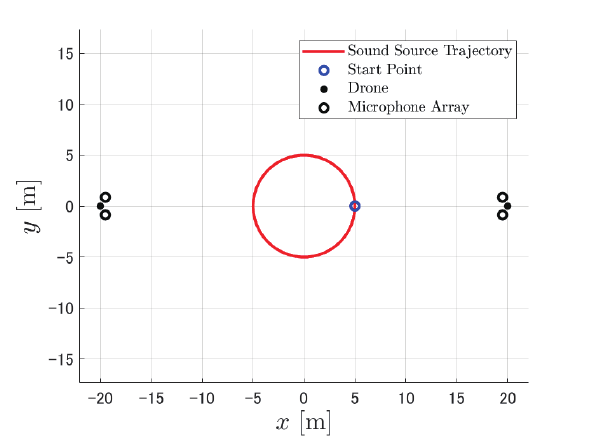
Figure 2. Top view of simulation scenario (horizontal distance = 30 m, sound source movement = circle).